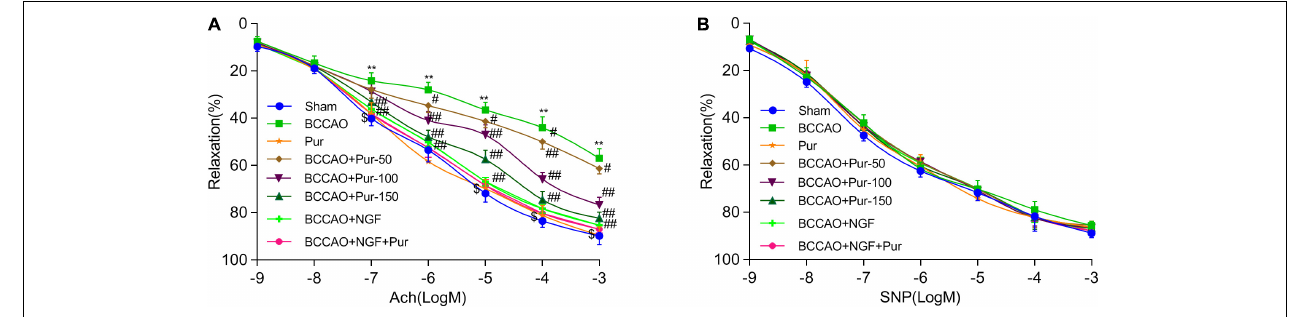
FIGURE 2 | Effects of Pur on middle brain artery relaxation. (A) Pur’s effect on acetylcholine-associated endothelium-dependent vasorelaxation in BCCAO rats. (B) Pur’s effect on sodium nitroprusside-associated endothelium-independent vasorelaxation in BCCAO rats. Values were mean ± SEM ( n = 6). ** P < 0.01 vs. Sham; # P < 0.05, ## P < 0.001 vs. BCCAO group; $ P < 0.05 vs. BCCAO + Pur (150